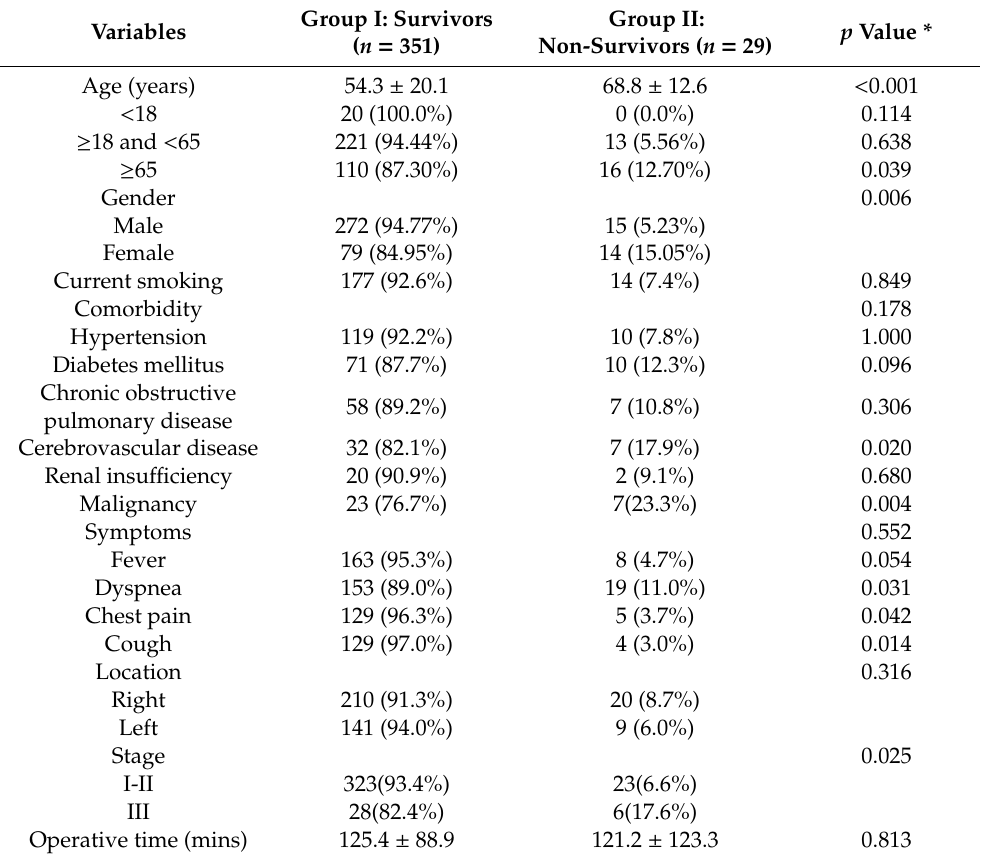
Table 1. Demographic data of